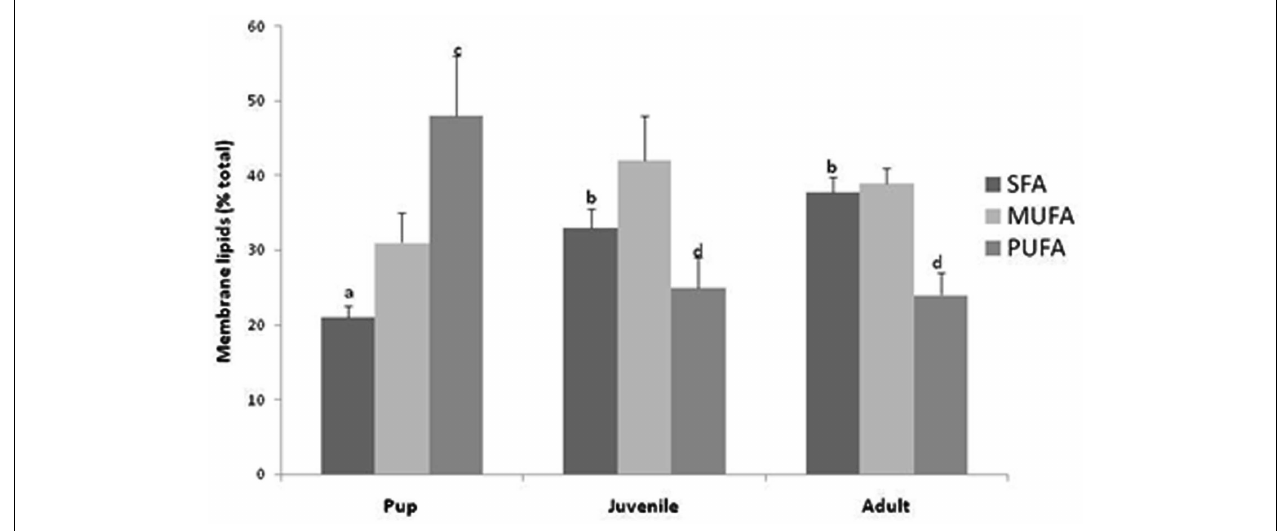
FIGURE 3 | Membrane (phospholipids) fatty acids (saturated, SFA; monounsaturated, MUFA; and polyunsaturated, PUFA) inWeddell seal skeletal muscle (pup, n = 5; juvenile, n = 5; adult, n = 5). Differences in lower case letters denotes statistical differences among age classes ( p < 0.05).